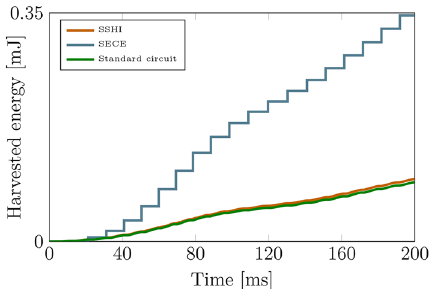
Fig. 13 Harvested energy ε of the bimorph PVEH with standard, SSHI and SECE circuit under a harmonic base acceleration of 9.81 m/s 2 and a frequency of